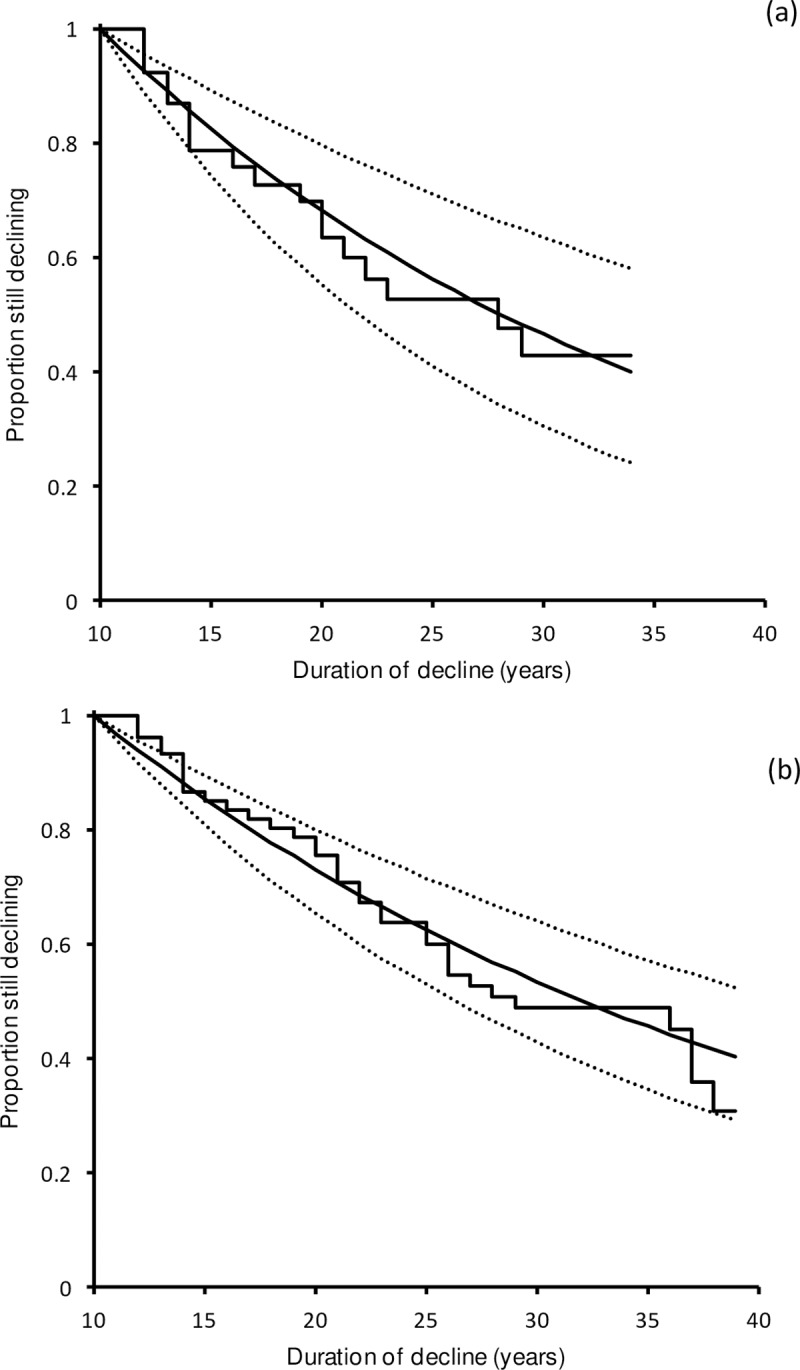
Kaplan-Meier diagrams showing the proportion of SPDs of UK birds in the period 1970–2013 that were still in progress, in relation to the number of years elapsed since they began or were first detected.The upper panel (a) shows the proportion of declines still in progress for the 43 declines with a well-defined start date. The solid curve shows the fitted exponential maximum-likelihood model. The dotted curves are 95% bootstrap confidence limits. The lower panel (b) shows the proportion of declines still in progress for all 82 declines in relation to time elapsed since the decline started or the beginning of the time series, including data for SPDs for which the start date was not well-defined.